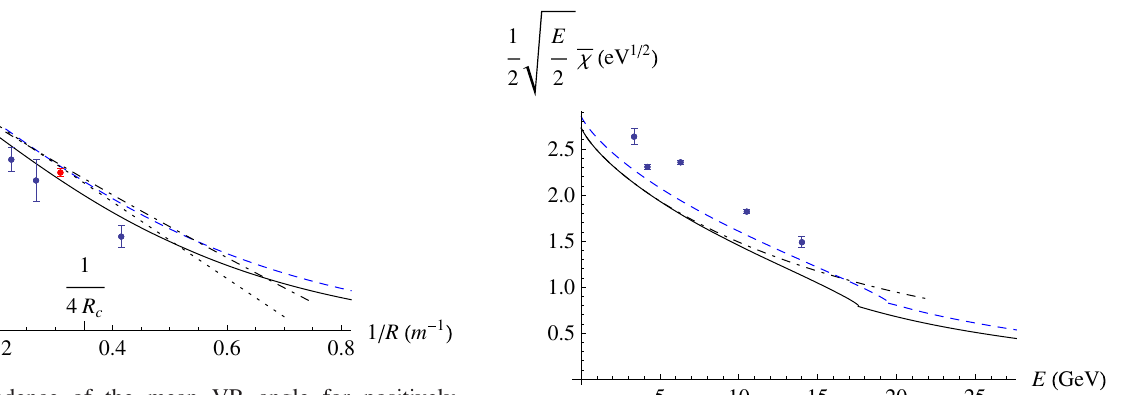
FIG. 6. Dependence of the mean VR angle for positively charged particles with energy E ¼ 400 GeV in silicon crystal in orientation (110) on the crystal curvature. Points, measure- ments in different experiments: blue, [24]; green, [5]; red, [9]. Curves: blue dashed, Moli`ere potential [with ordinary screening radius (81)] at room temperature [Eq. (77)]; black solid, HF potential (92); black dot-dashed, NLO prediction for HF poten- tial, Eqs. (28) and (29); black dotted, static NLO prediction for HF potential, Eq. (25).